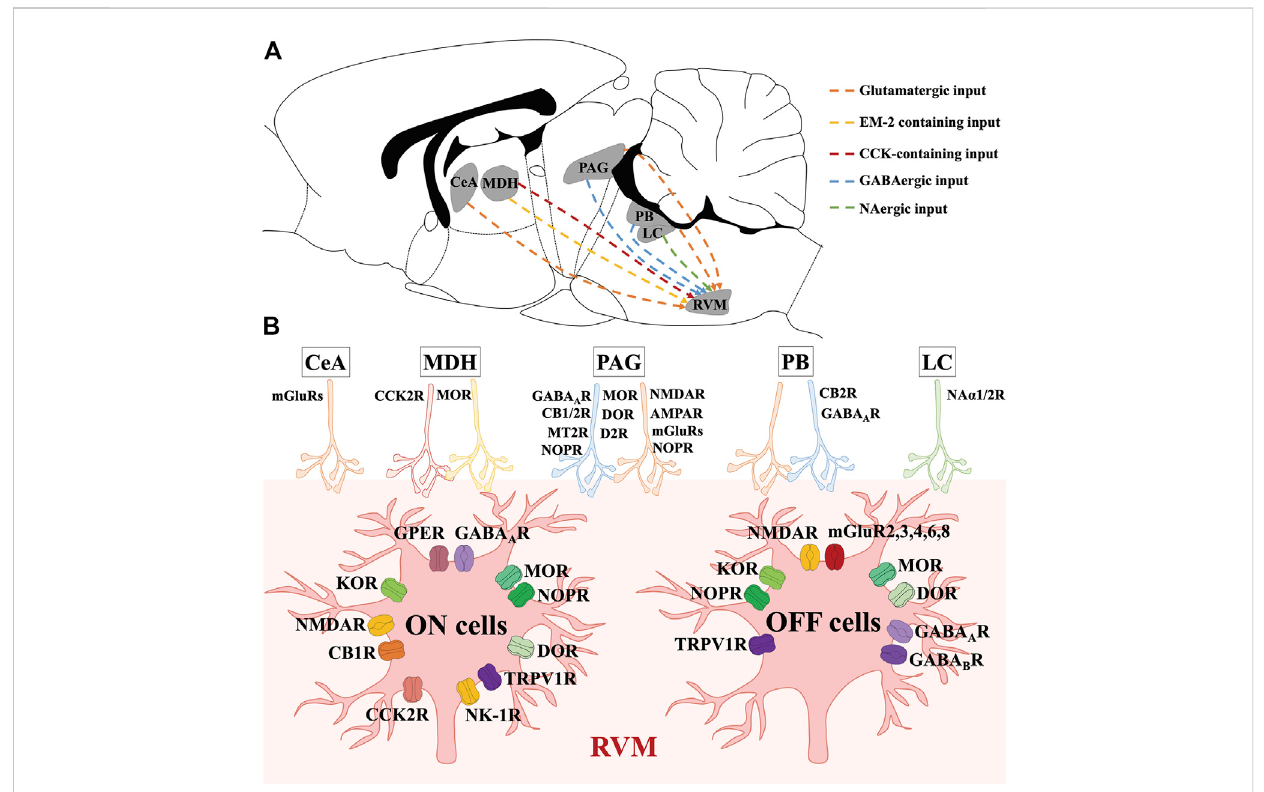
Molecular characteristics of neural circuits and transmitters modulating RVM ON and OFF cells. (A) shows the anatomical location of nucleus and neuralcircuitsprojectingtotheRVM ONandOFFcellsinthemouse brain. (B) showsthetransmitters andreceptorswhichparticipateinmodulating RVM ON and OFF cells. CeA mainly act on glutamate receptors to exert modulations on RVM ON and OFF cells. By binding to MOR and CCK2R, DMH EM-2 containing inputs and CCK-containing inputs modulate RVM ON and OFF cells. Via acting on opioid, cannabinoid, GABA, glutamate, dopamine, TRPV1, and melatonin receptors, PAG GABAergic and glutamatergic inputs modulate RVM ON and OFF cells. PB GABAergic and glutamatergic neurons modulate RVM ON and OFF cells by binding to cannabinoid, and GABA receptors. LC NAergic neurons act on Na α receptors to modulate RVM ON and OFF